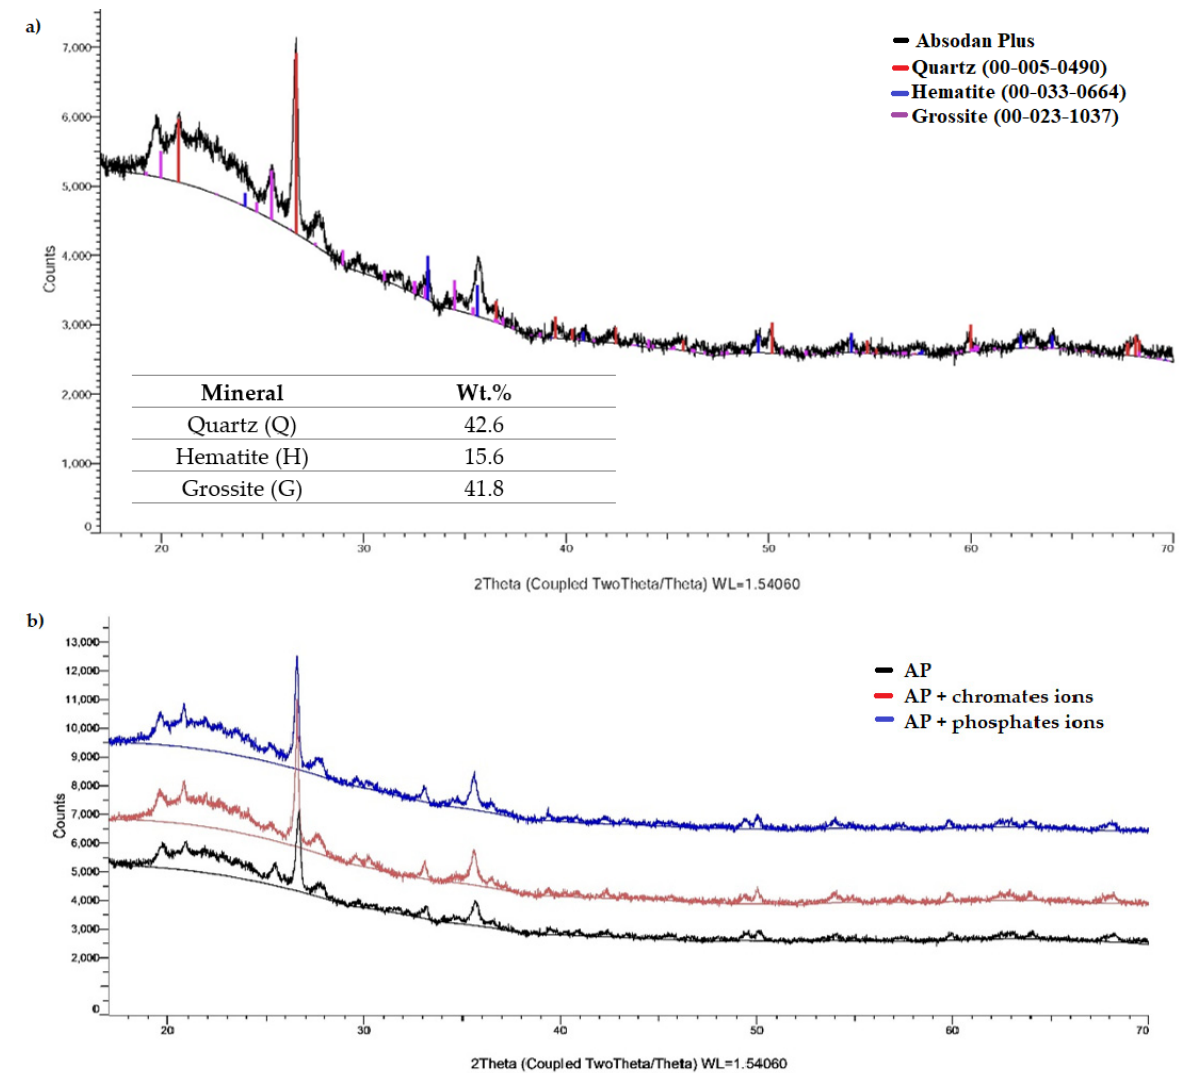
Figure 3. XRD diffractograms of: ( a ) Absodan Plus, ( b ) Absodan Plus with chromates and phos- phates ions. Table 4. Crystallinity and the amorphous ratio of Absodan Plus take into account the size of crys- tallites.